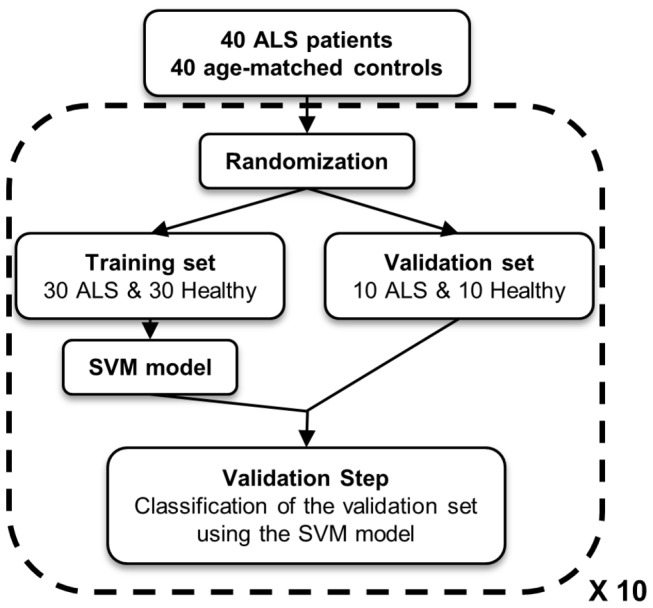
Workflow of the SVM model generation.Data were randomly separated into two data sets, a training set (30 ALS patients and 30 healthy controls) used for the biomarker discovery step and a validation set used for classification of blinded samples (10 ALS patients and 10 healthy controls). This process of data randomization, discovery and validation was repeated ten times.